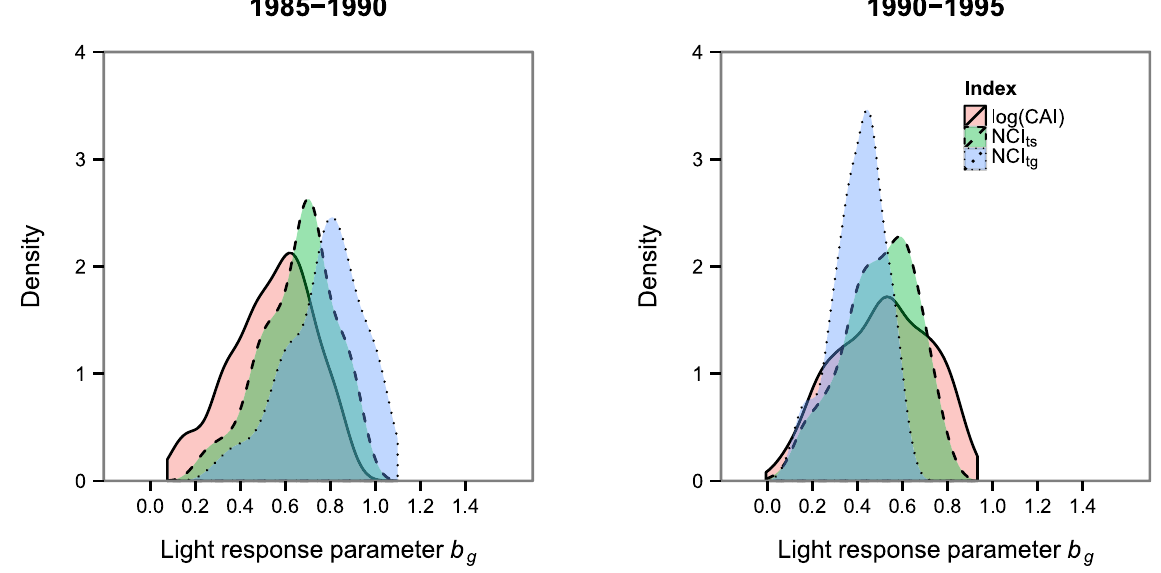
Figure 7. Community-wide distribution of the light response of growth ( b g ). Light is estimated either with the canopy index (log(CAI)), the interval-specific neighbordood competition index (NCI ts) or the general neighborhood competition index (NCI tg) . The underlying histogram can lead to sharp edges of the density plot.